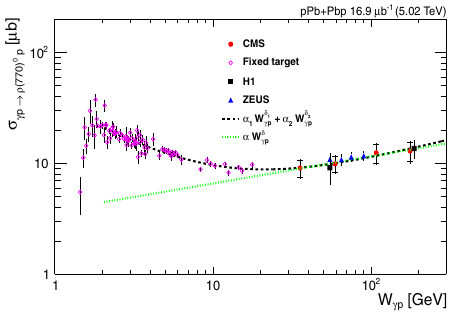
Figure 4. Exclusive ρ meson cross sections measured as a function of W γ p [4]. The inner and outer error bars show the statistical uncertainty and systematic uncertainty. The dashed black line shows the result of the Regge fit